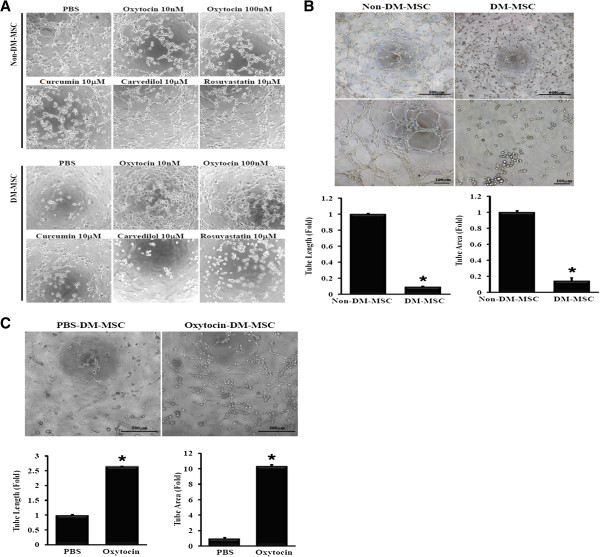
Impaired tube formation of MSC from DM bone marrow was restored by oxytocin. (A) MSCs were pretreated with PBS, oxytocin, curcumin, carvedilol, or rosuvastatin prior to tube formation assay. (B) Representative images from the in vitro angiogenesis assay showed the retarded tube formation in DM-MSC. Both tube length and tube area were measured and expressed in graphs (n=5). (C) Representative images of tube formation of DM-MSC after treatment with PBS or 100 nM of oxytocin for 24 hours were presented (n=4). * p < 0.01 vs. Non-DM-MSC.